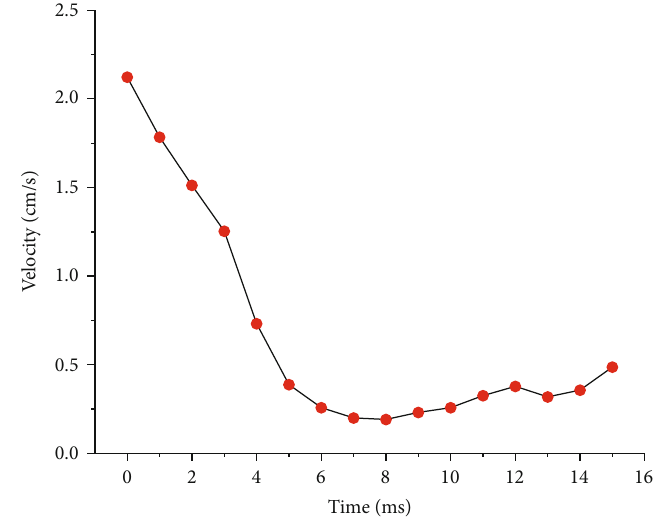
Figure 9: Negative peak vibration velocity after superposition of di ff erent millisecond